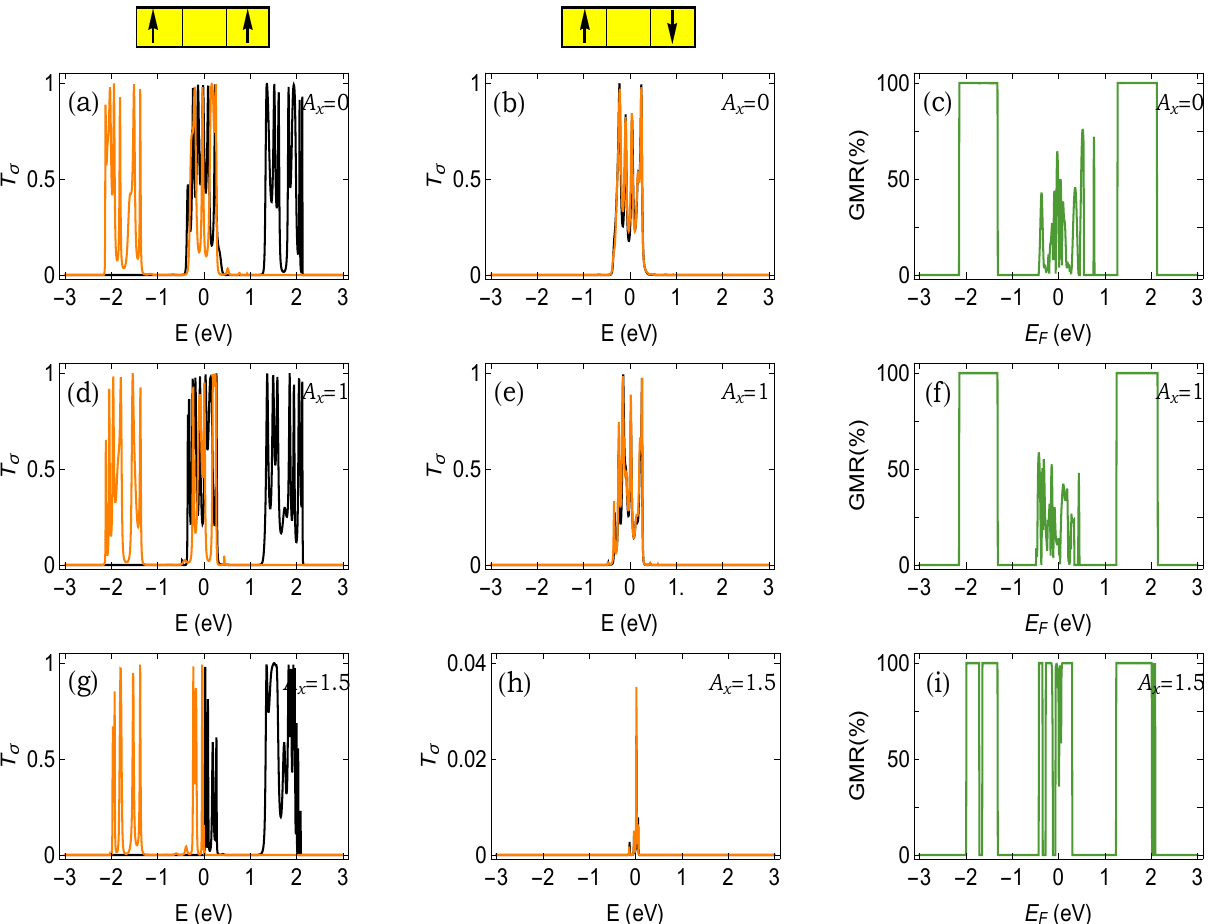
Figure 2. ( a – i ) (Color Online). Transmission probabilities T σ as a function of energy (first and second columns, T ↑ → orange, T ↓ → black) and GMR as a function of Fermi energy (last column) under three typical values of light parameter A x . AAH phase φ ν =